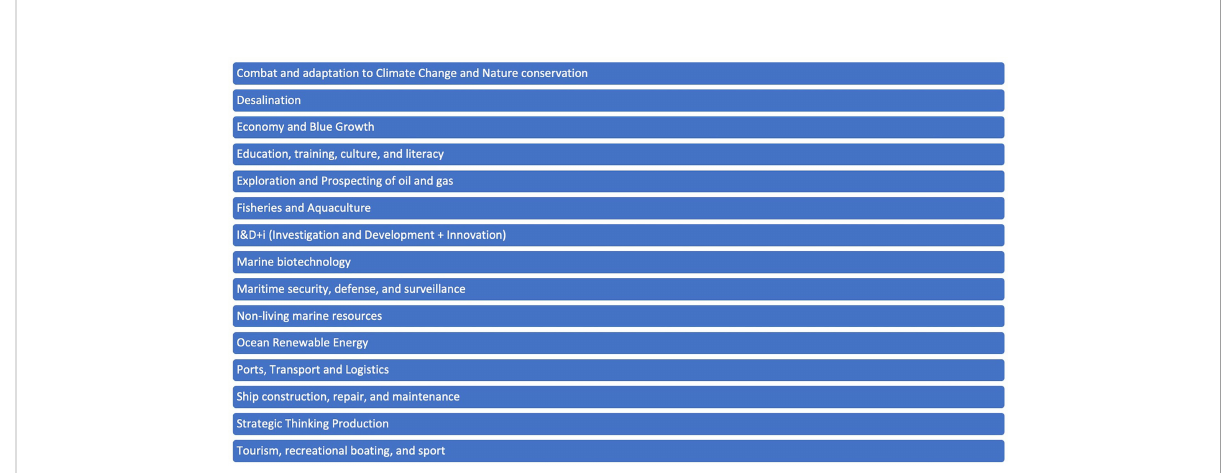
FIGURE 2 Most relevant socio-economic sectors in the context of the Atlantic Basin of the European Union. The socio-economic sectors identi fi ed belong to the Blue Growth and Blue Economy intervention areas. However, it was found that most of the countries under study have speci fi c measures for both Blue Growth and Blue Economy, which are not included in the other socio-economic sectors. For this reason, and for this study, the socio-economic sector ‘ Economy and Blue Growth ’ was